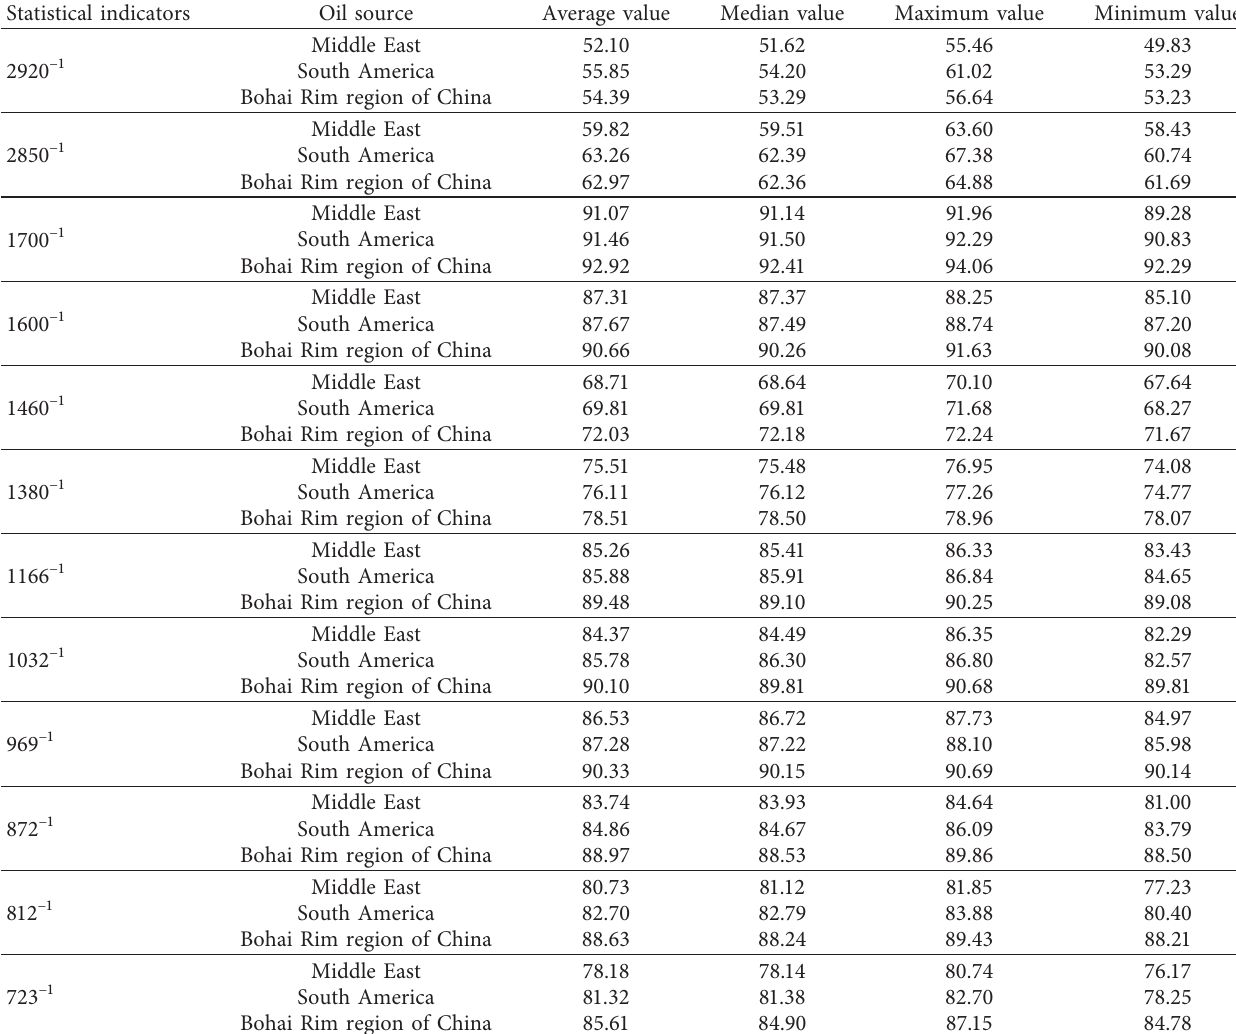
Table 2: Descriptive statistics analysis of the 12 CAPs.